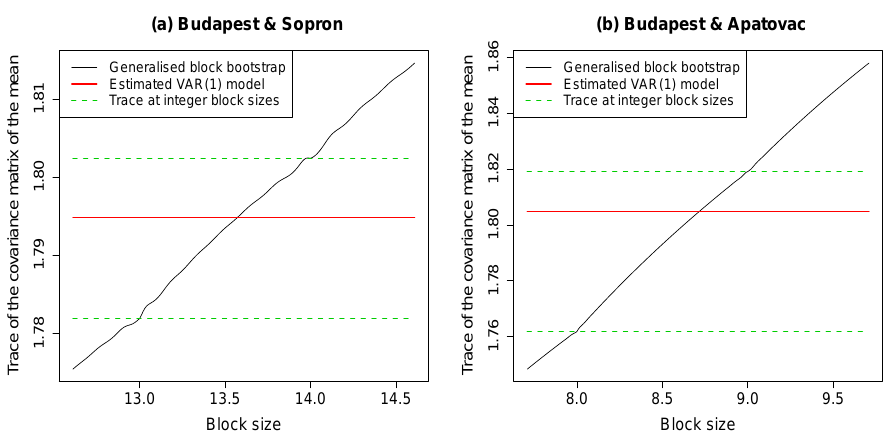
Figure 4. (a) The trace of the covariance matrix of the mean for two selected grid points near Budapest and Sopron; (b) the trace of the covariance matrix of the mean for two selected grid points near Budapest and Apatovac (first half of the sample). Table 6. Optimal block length for the first half of the samples for the five selected pairs of grid points. Pairs of selected grid points